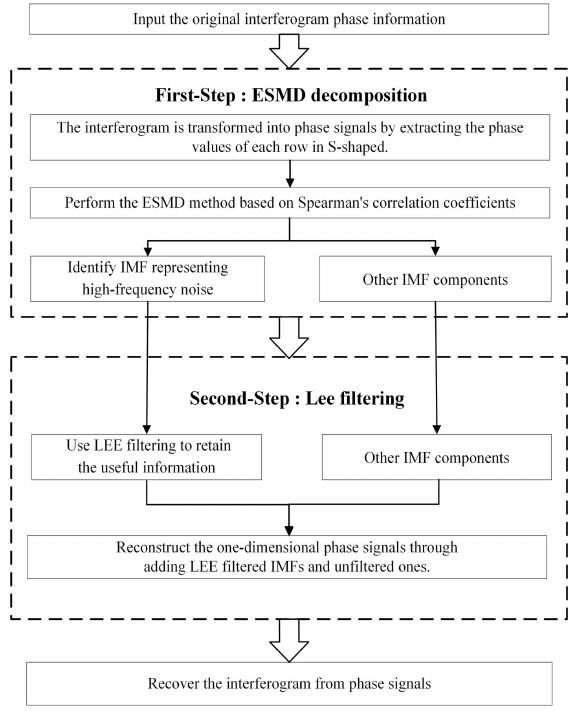
Figure 1. Overall technical framework of the multi-step de- noising